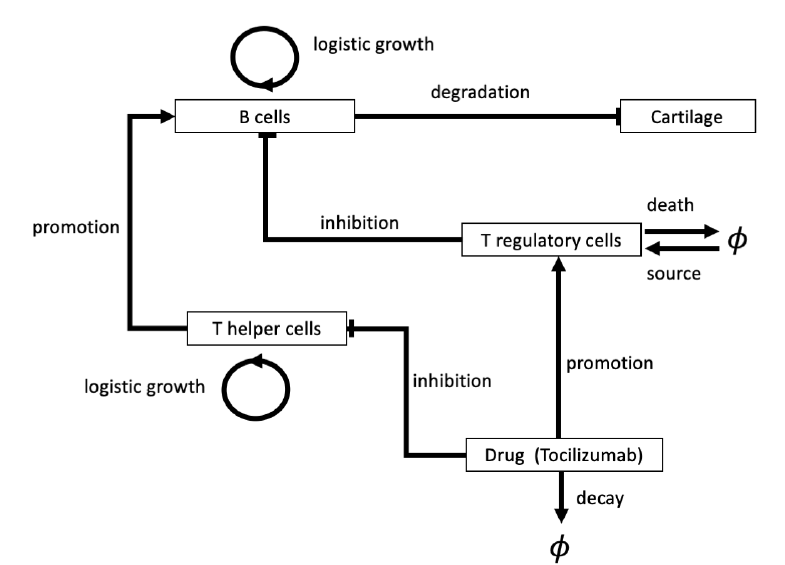
Figure 5. Schematic describing the chemicals, cells and processes included in model described in [72]. The models considers five variables; B cells, T helper cells, T regulatory cells, cartilage and the drug TCZ, along with the interactions between these components. Note that, here φ represents objects outwith or removed from the